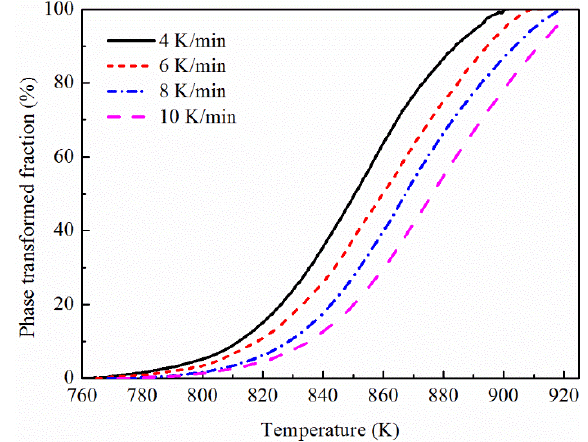
Figure 3. Phase transformed volume as a function of temperature of Al 0.25 CoCrFeNi high-entropy alloy measured at different heating rates.